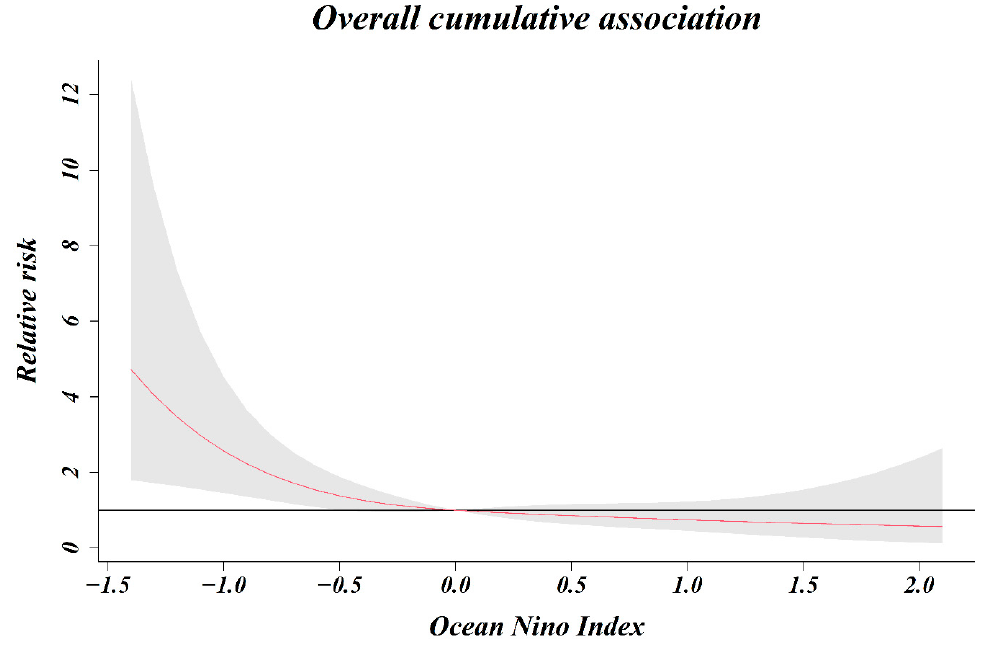
Figure 5. Overall cumulative association (relative risk and ONI).